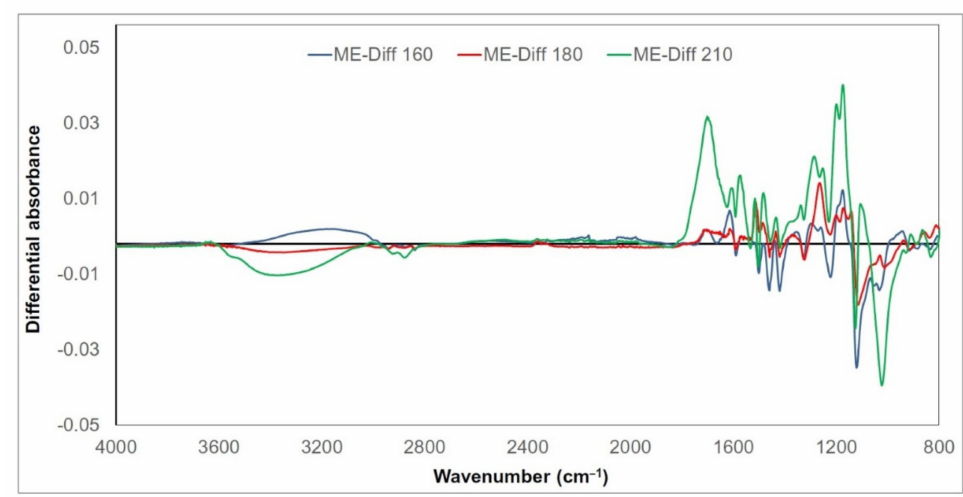
Figure 4. Differential FTIR spectra of thermally treated meranti wood lignin.